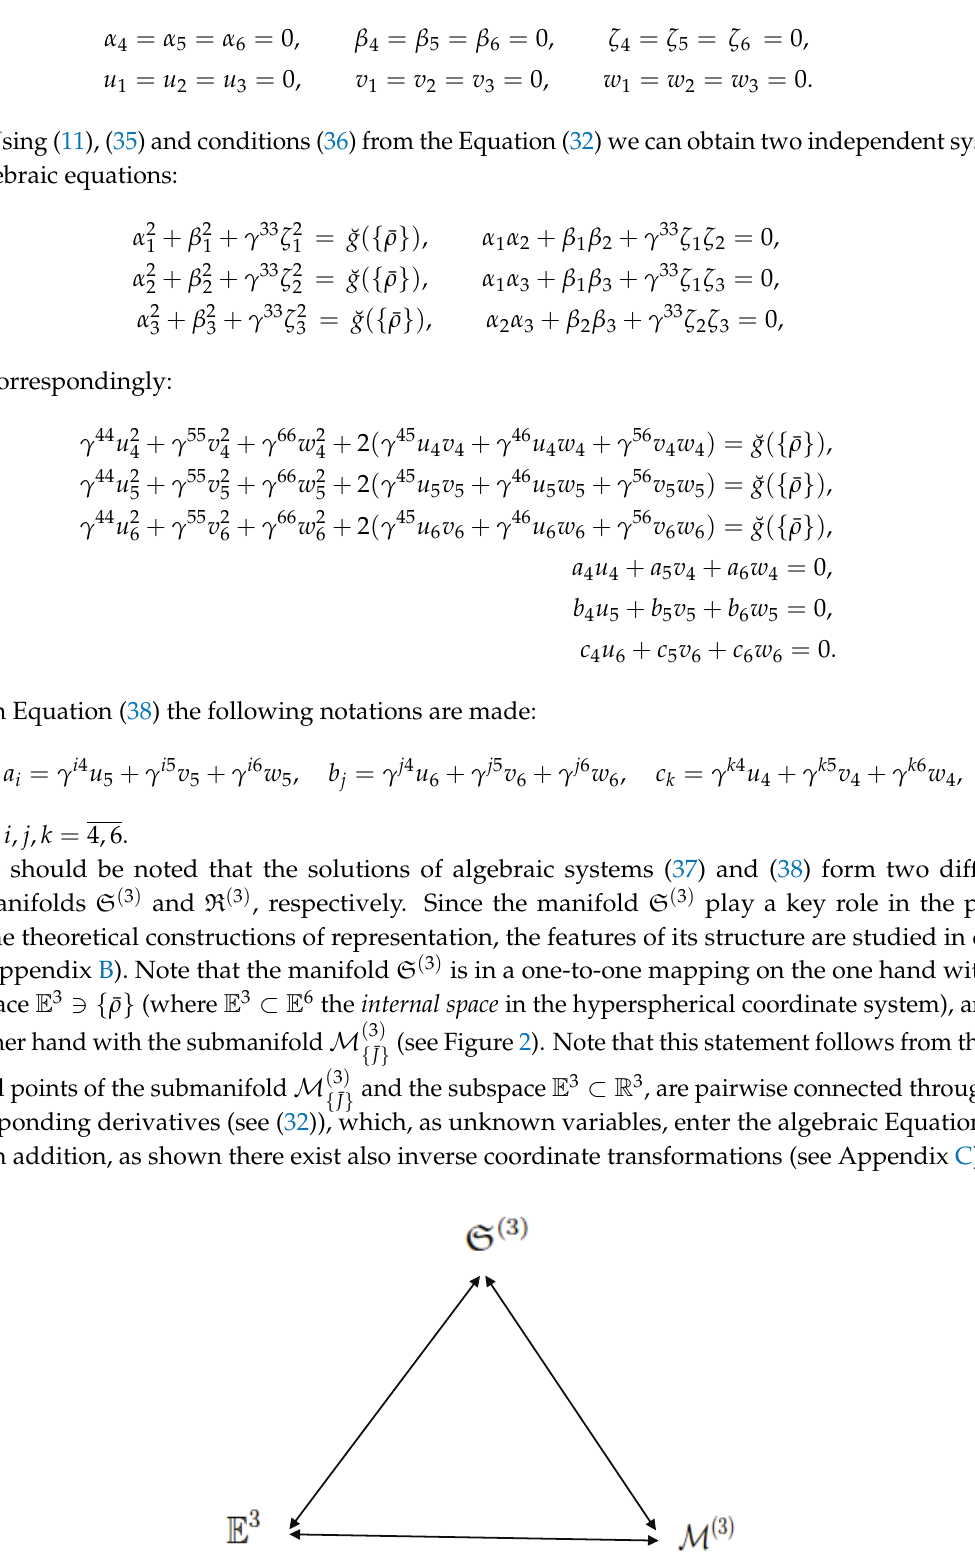
Figure 2. In this diagram all spaces are homeomorphic to each other, i.e., E 3 (cid:39) S ( 3 ) (cid:39) M ( 3 )